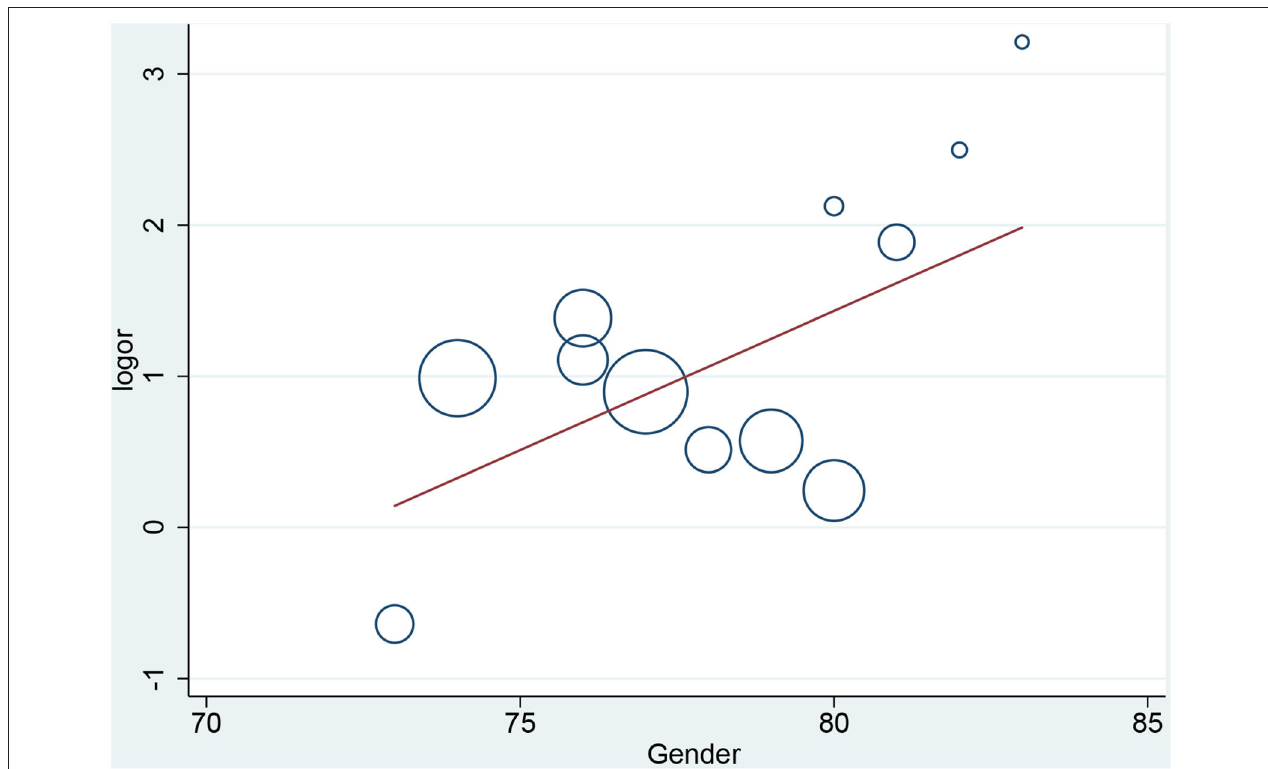
FIGURE 5 | Meta-regression for gender as an influence factor of macrophage accumulation in overall population.